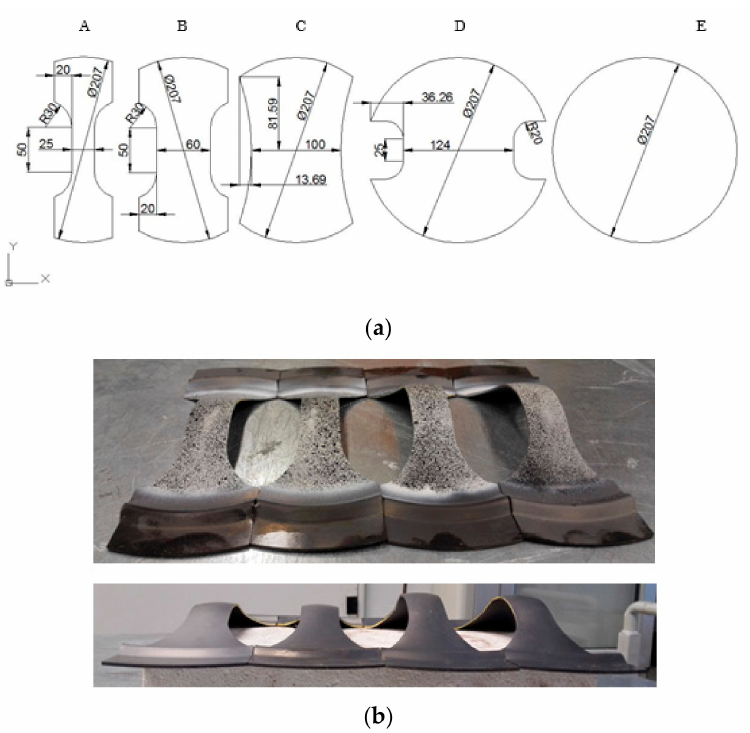
Figure 6. Forming limit of Inco718 samples. ( a ) Sample geometry and ( b ) pre-strain